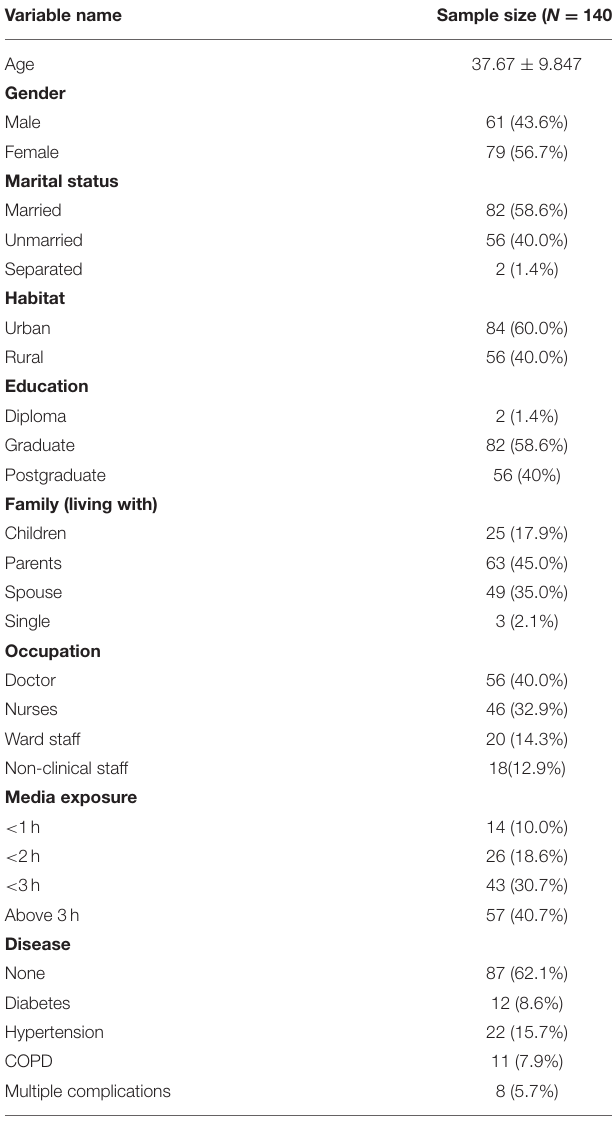
TABLE 1 | Socio-demographic details of the